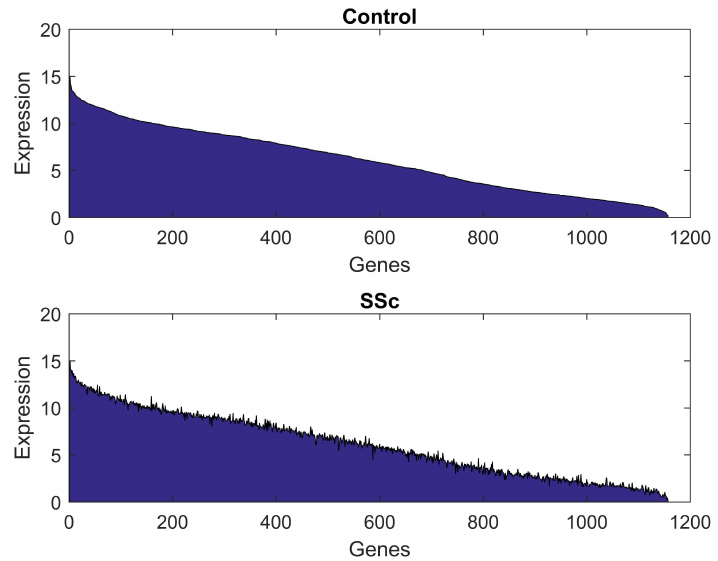
Figure 5. Mean gene expression for controls and patients.